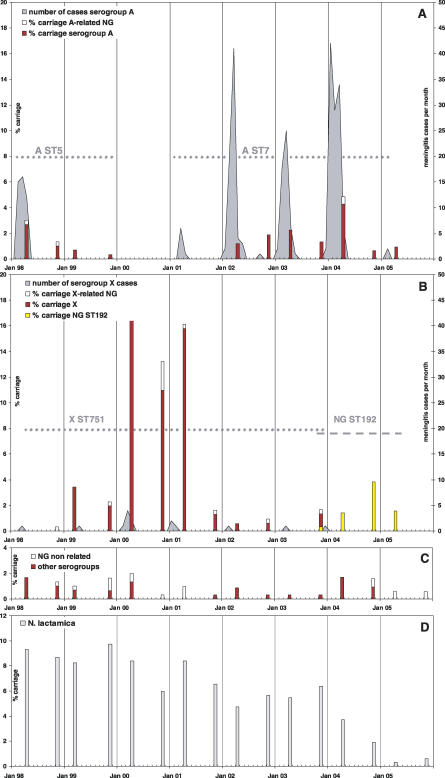
Waves of Colonisation and Disease in the KND from April 1998 until November 2005Carriage rates recorded during 16 colonisation surveys (April and November each year) and monthly numbers of confirmed meningitis cases of N. meningitidis.
(A) Genoclouds of serogroup A ST5 and ST7 meningococci are shown.(B) Genoclouds of serogoup X ST851 and NG ST192 meningococci are shown.(C) Carriage rates of other serogroups and meningococci unrelated to the A, X, or NG ST192 genoclouds are shown.(D) Carriage rates of N. lactamica are shown.